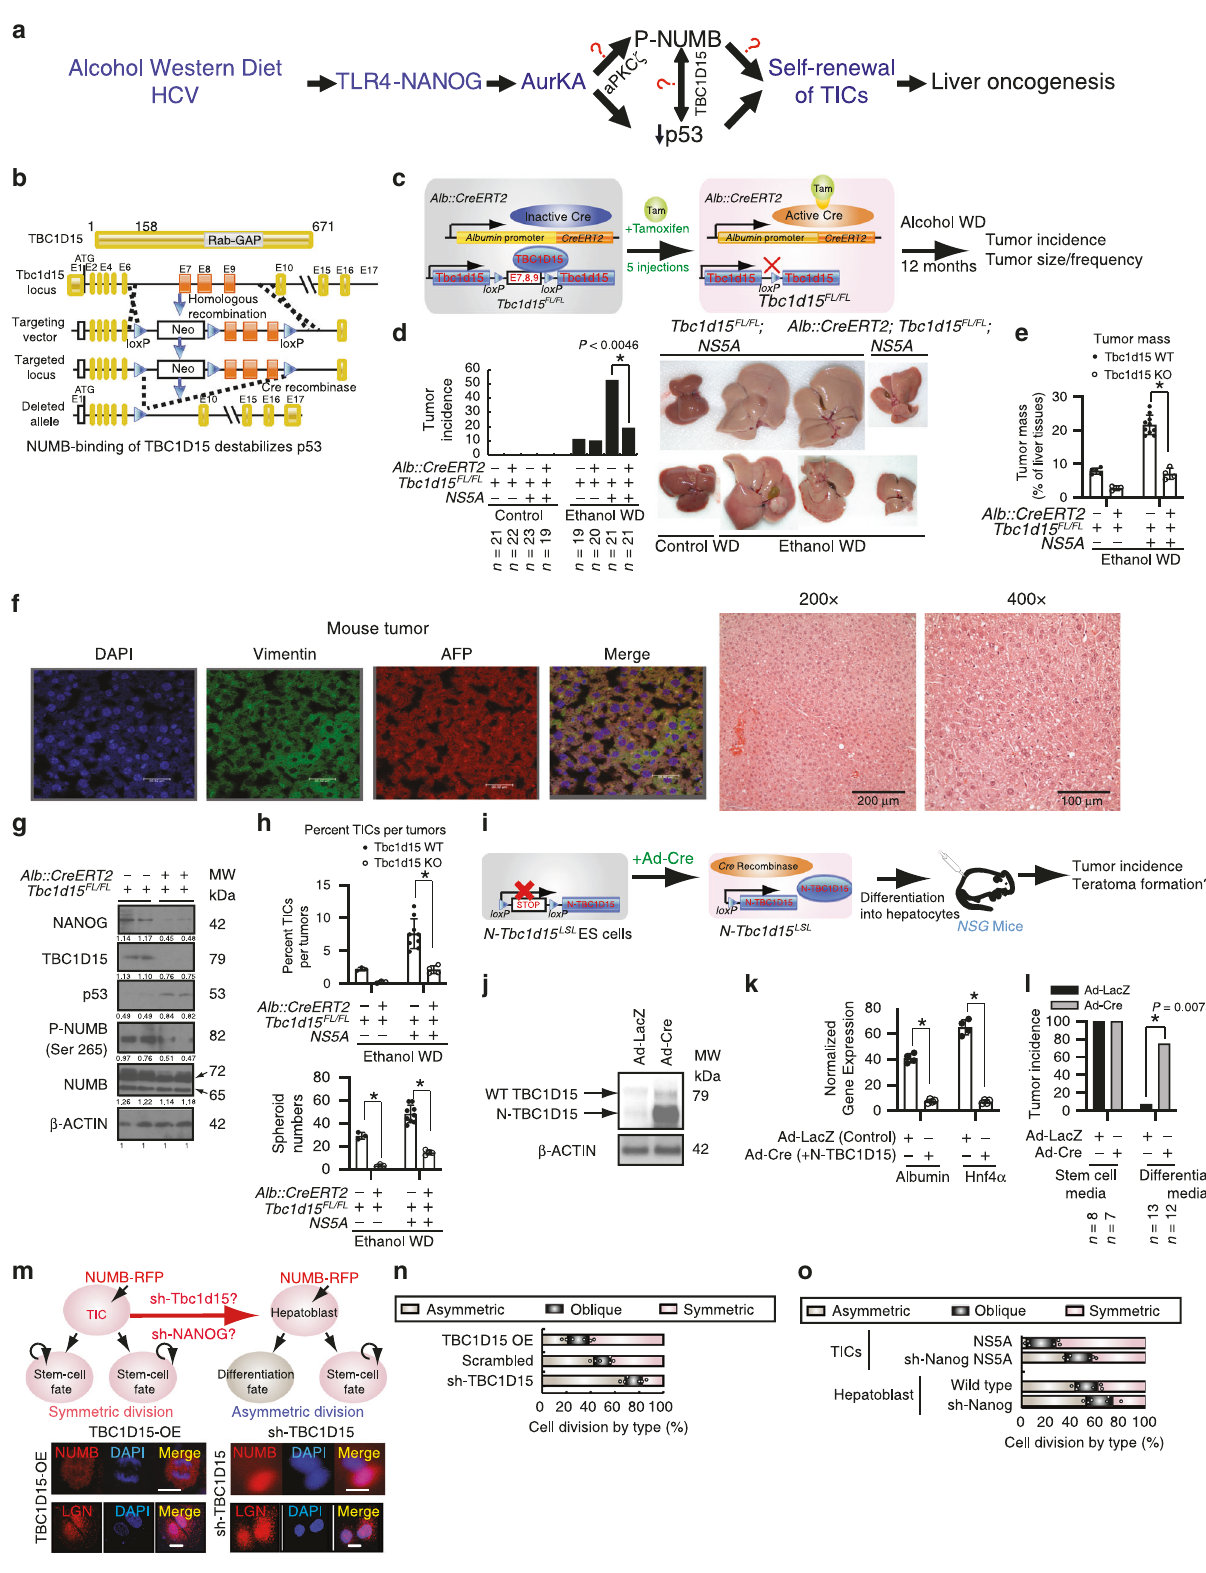
TBC1D15 interacts with NuMA1 and prevents NuMA1 – LGN interaction . While we have shown TBCD1D15 was required for p53 degradation facilitated by NUMB phosphorylation, the mechanism by which TBC1D15 regulates NUMB phosphoryla- tion is unknown. To this end, we searched for in vivo partners